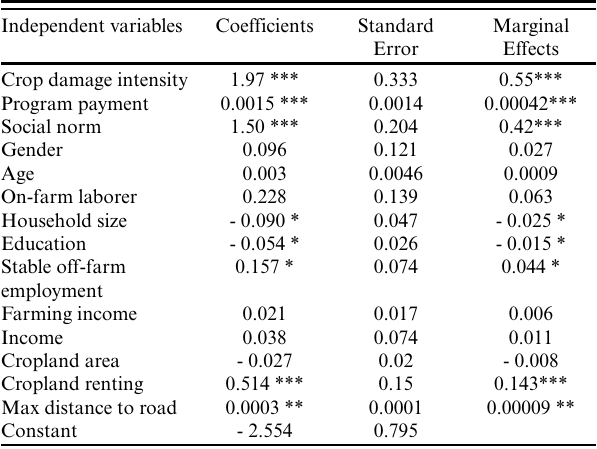
Table 2 . Estimation of model coefficients for scenario attributes and other characteristics and their marginal effect on the households’ willingness to participate in future Grain to Green